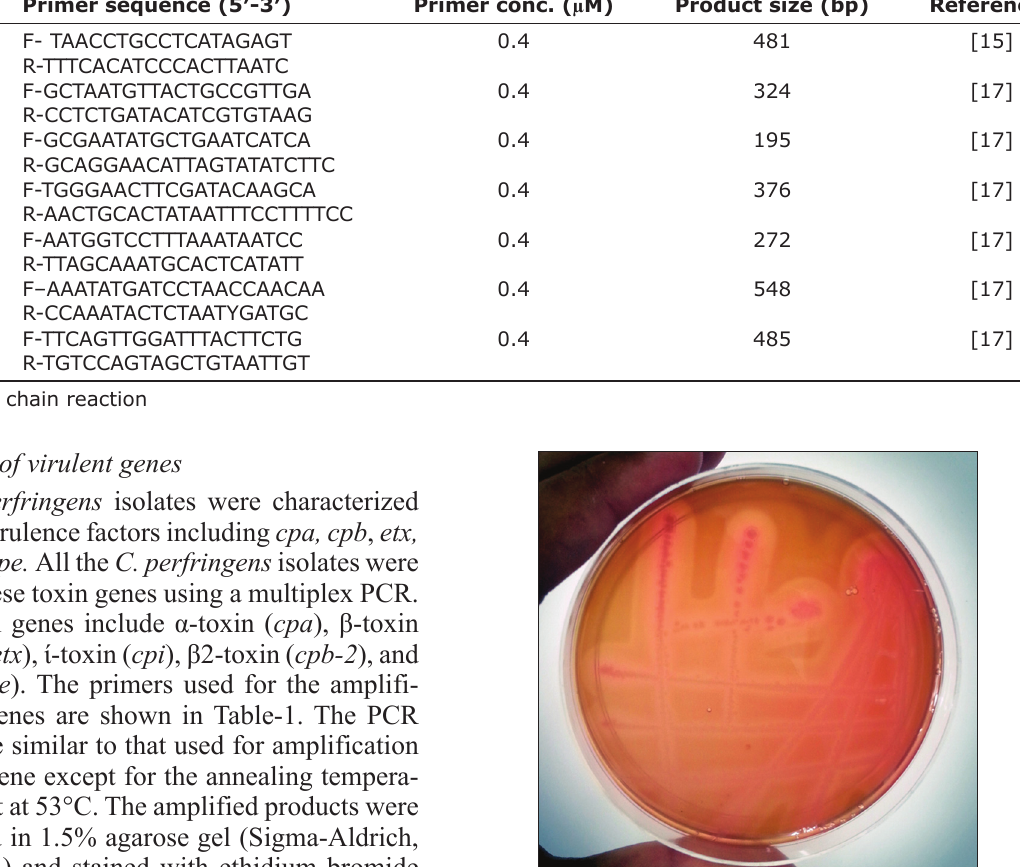
Table-1: List of primers used in PCR for amplification of Clostridium perfringens toxin genes. Target gene Primer sequence (5′‑3′)